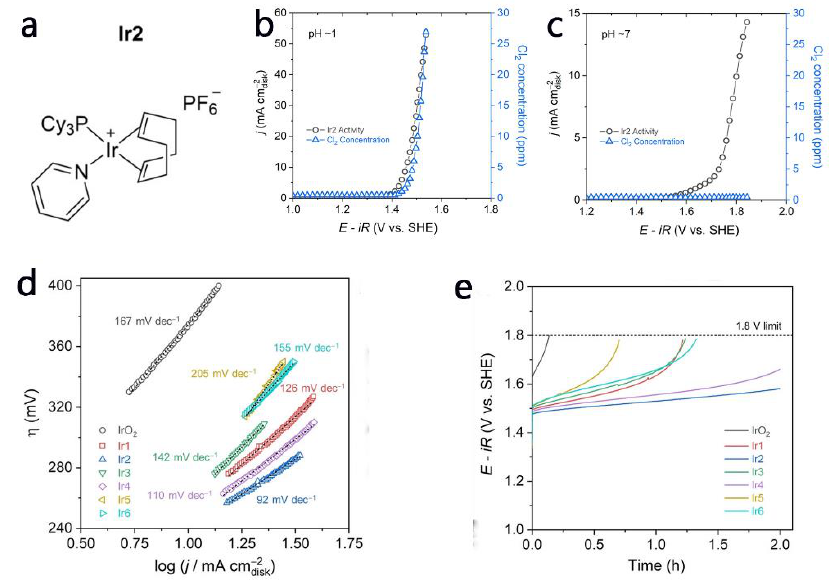
Figure 2. ( a ) Ir-based organometallics subject to pyrolysis with activated carbon: (1,5-cyclooctadiene)(pyridine)(tricyclohexylphosphine)-iridium(I) hexafluorophosphate [34]. The activity of the Ir catalyst and the concentration of produced Cl 2 ( b ) at pH = 1 and ( c ) at pH = 7 (synthetic seawater) [34]. ( d ) Tafel slopes and ( e ) Stability tests of IrO 2 , and Ir1–Ir6 at 10 mA cm − 2 [34]. Adapted with permission Ref. [34], Copyright 2020, Wiley-VCH.